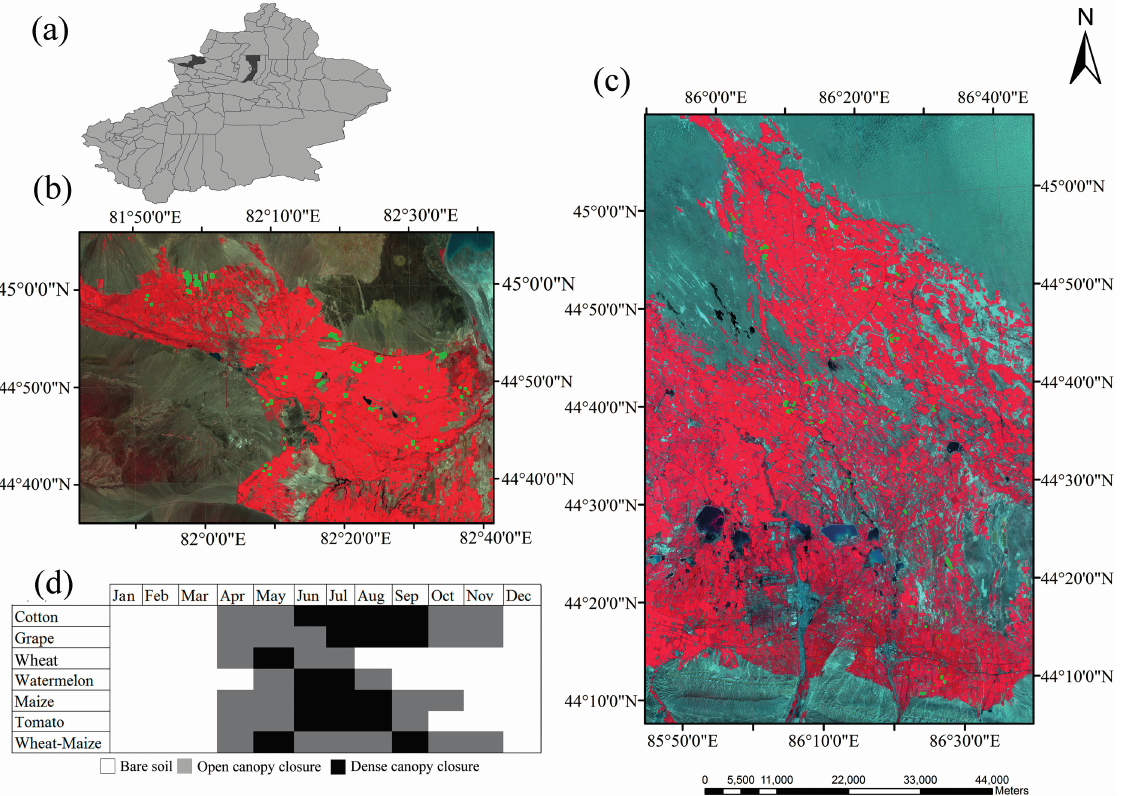
Figure 1. Study areas. ( a ) Location of Bole and Manas Counties in Xinjiang. ( b ) Bole (11 July 2011); and ( c ) Manas (13 July 2011). The images are standard false color composites of Landsat-5 TM. The green patterns on the images show the distribution of ground-truth data. ( d ) Vegetation cover fractions for different crop types over the course of a